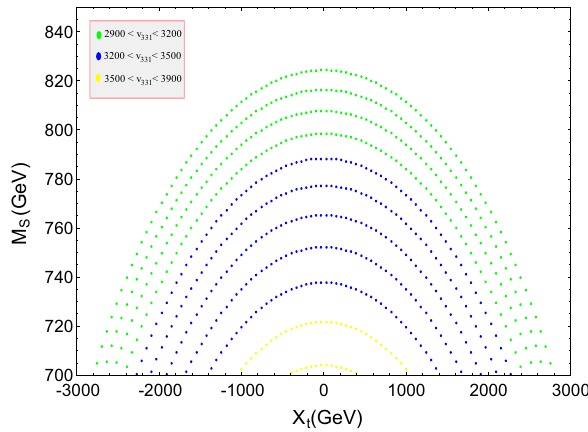
Fig. 3 M s versus X t for various values of v 331